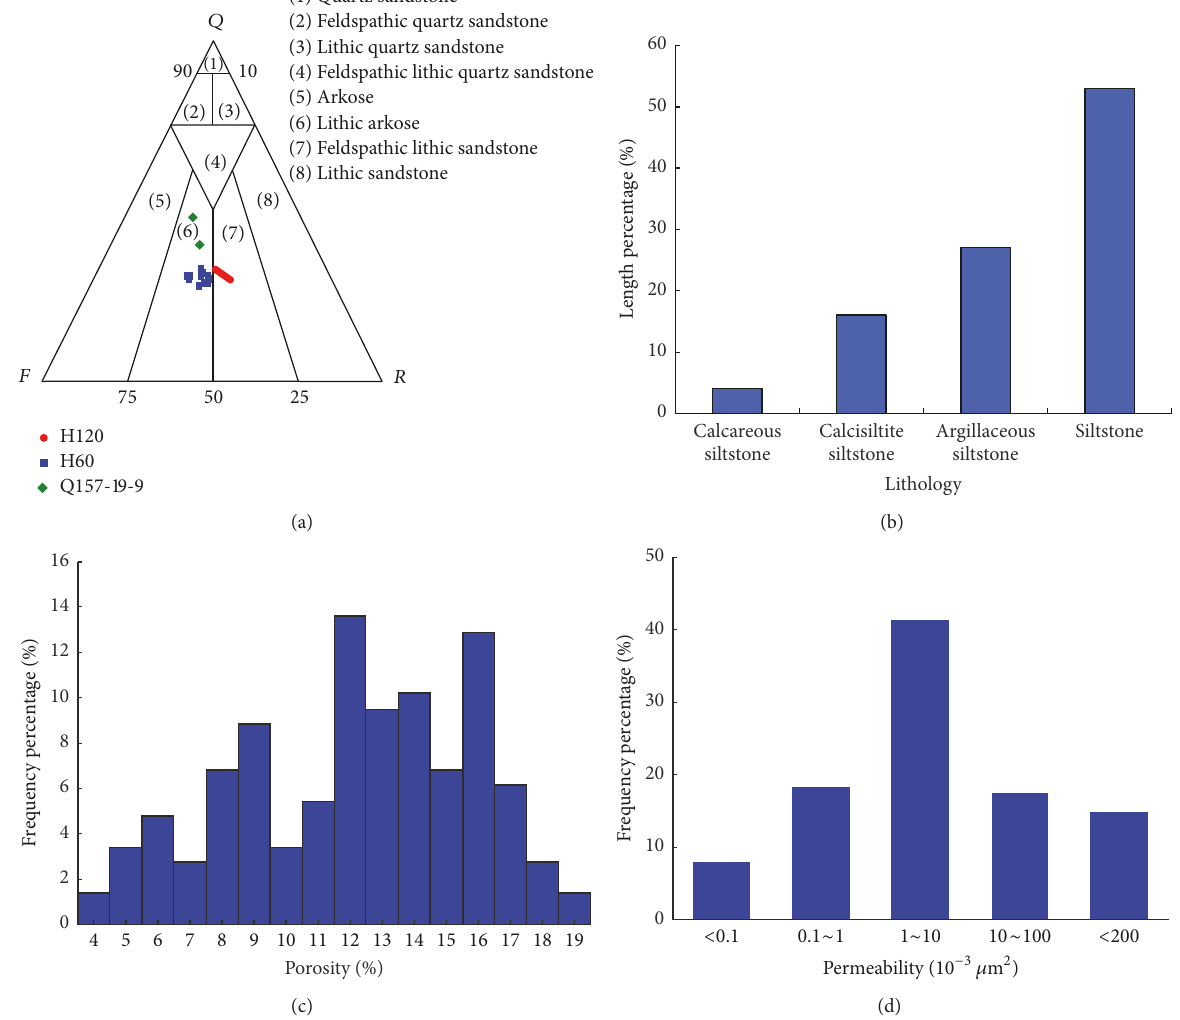
Figure 3: Diagram of lithology and physical property of the core well at Daqingzijing area. (a) Rock type. (b) Lithologic distribution histogram. (c) Porosity distribution histogram. (d) Permeability distribution